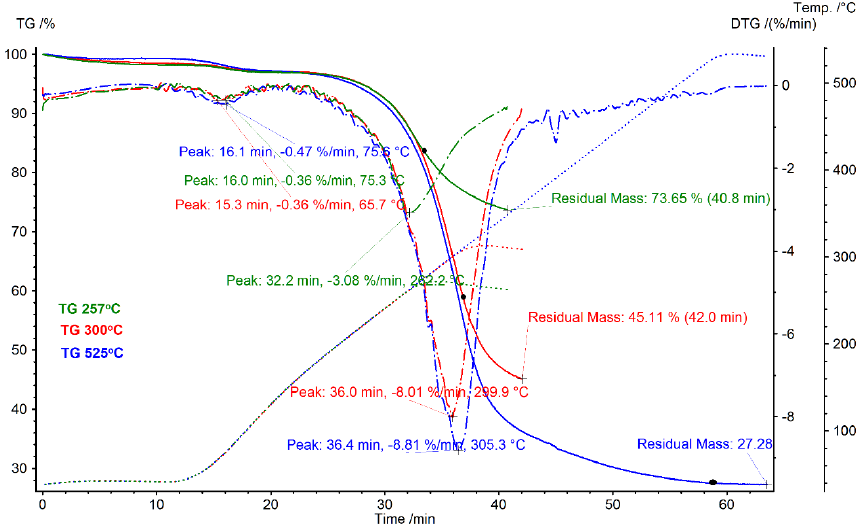
Figure 13. Summary of maize straw torrefaction curves with DTG curves.